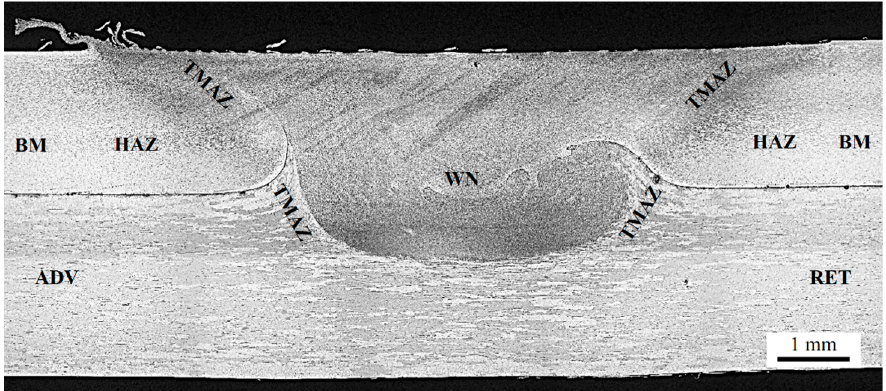
Figure 2. Cross-section and microstructural zones of a friction stir welding (FSW) lap joint produced using a conventional threaded tool at 1200 rpm and 250 mm/min. Tool translation movement was forward from the shown cross-section.